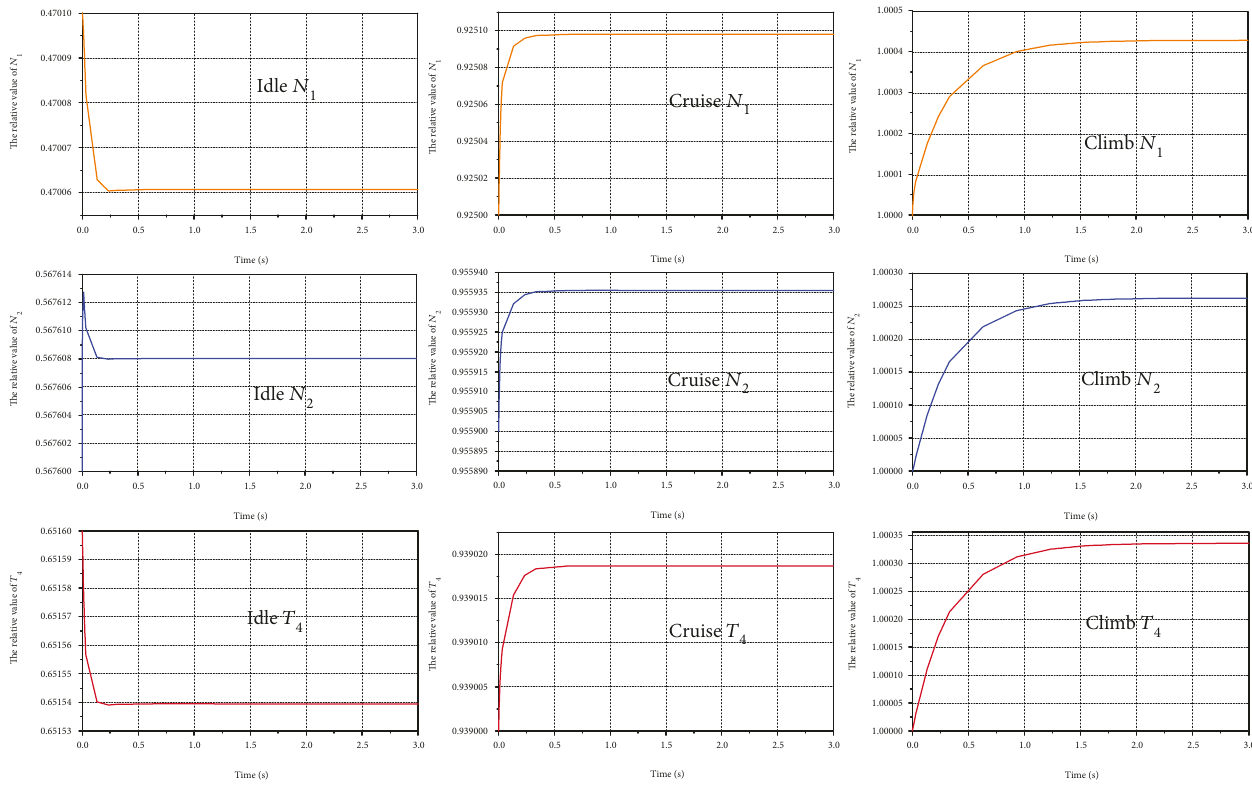
Figure 4: Simulation curves of steady